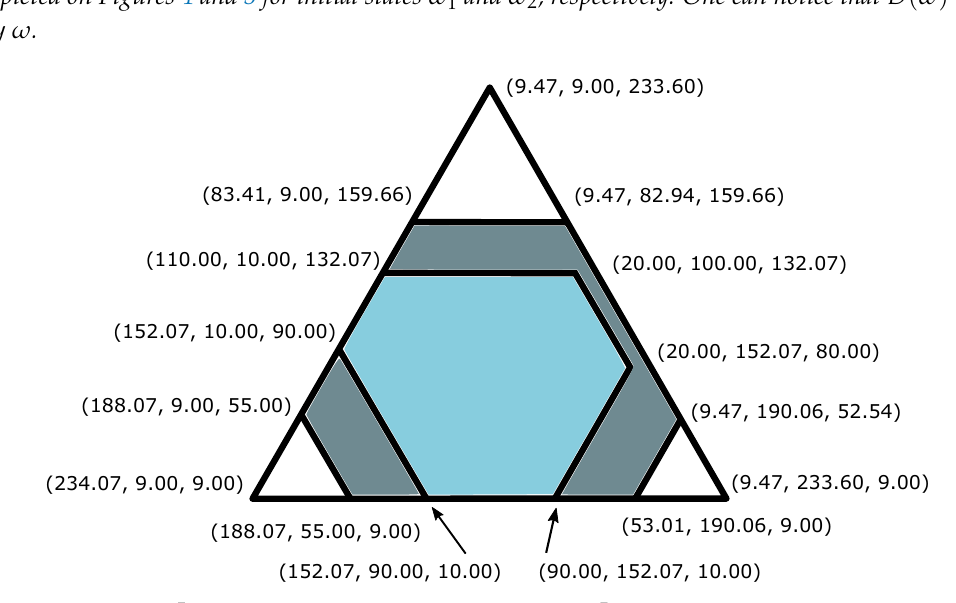
Figure 4. The core ¯ C ( ω ) (gray region) and approximated core ¯ D ( ω ) (blue region inside gray region) in stochastic game with ω 1 initial